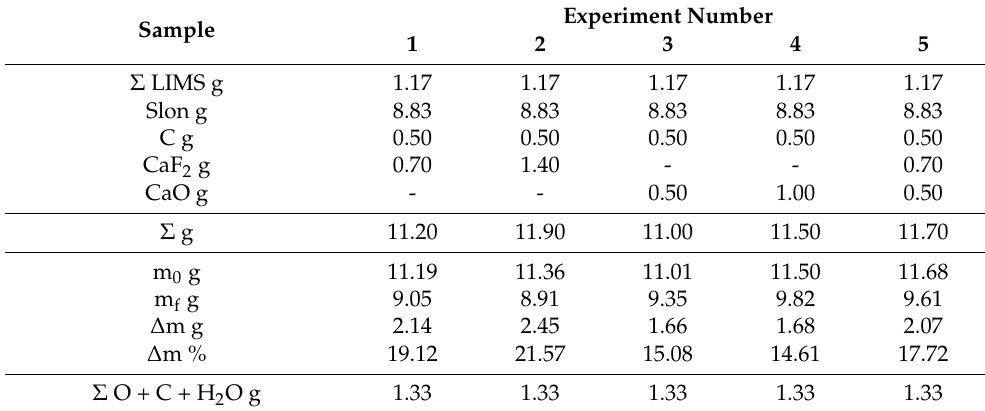
Table 4. Results of experiments 1–5 using the R2/l concentrate with various